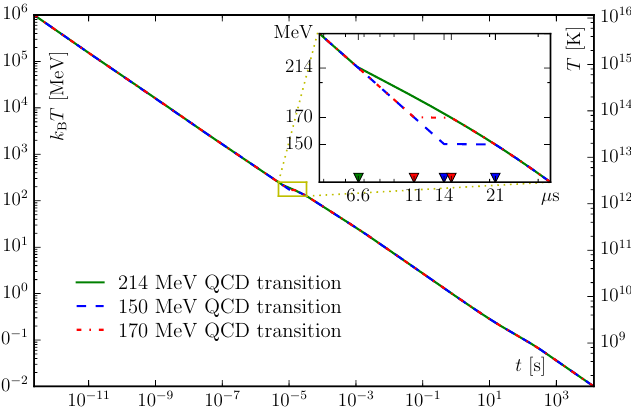
Figure 7. Energy and temperature as functions of time using the three different transition temperatures. For the k B T c = 214 MeV transition, the temperature will drop slower after T c , but nonetheless always decrease over time. For k B T c = 170 MeV and k B T c = 150 MeV, there will be a period with constant temperature and energy density while g ⋆ (cid:101) decreases from its quark-gluon value to its hadron gas